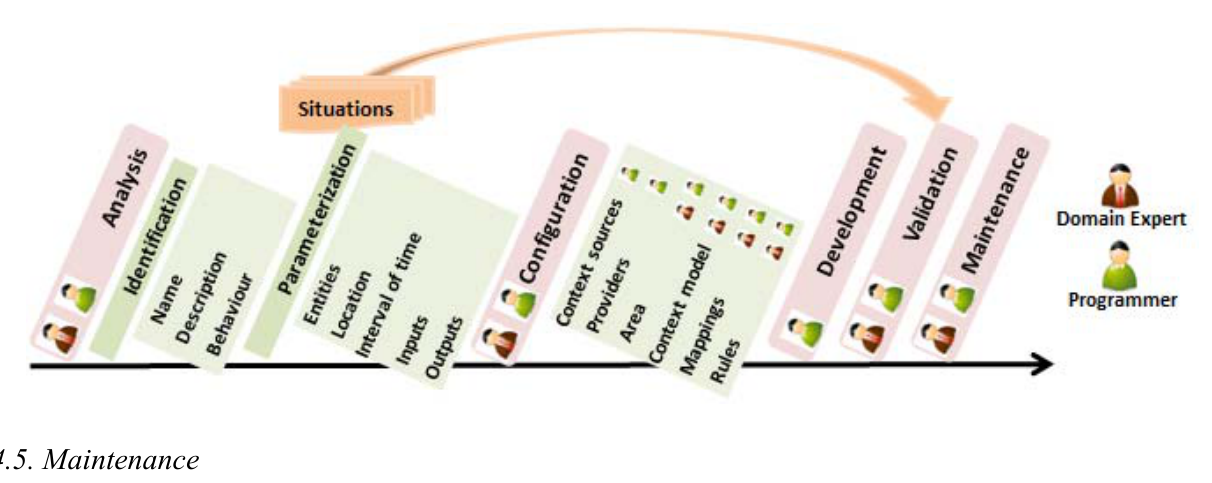
Figure 2. Situation-Driven